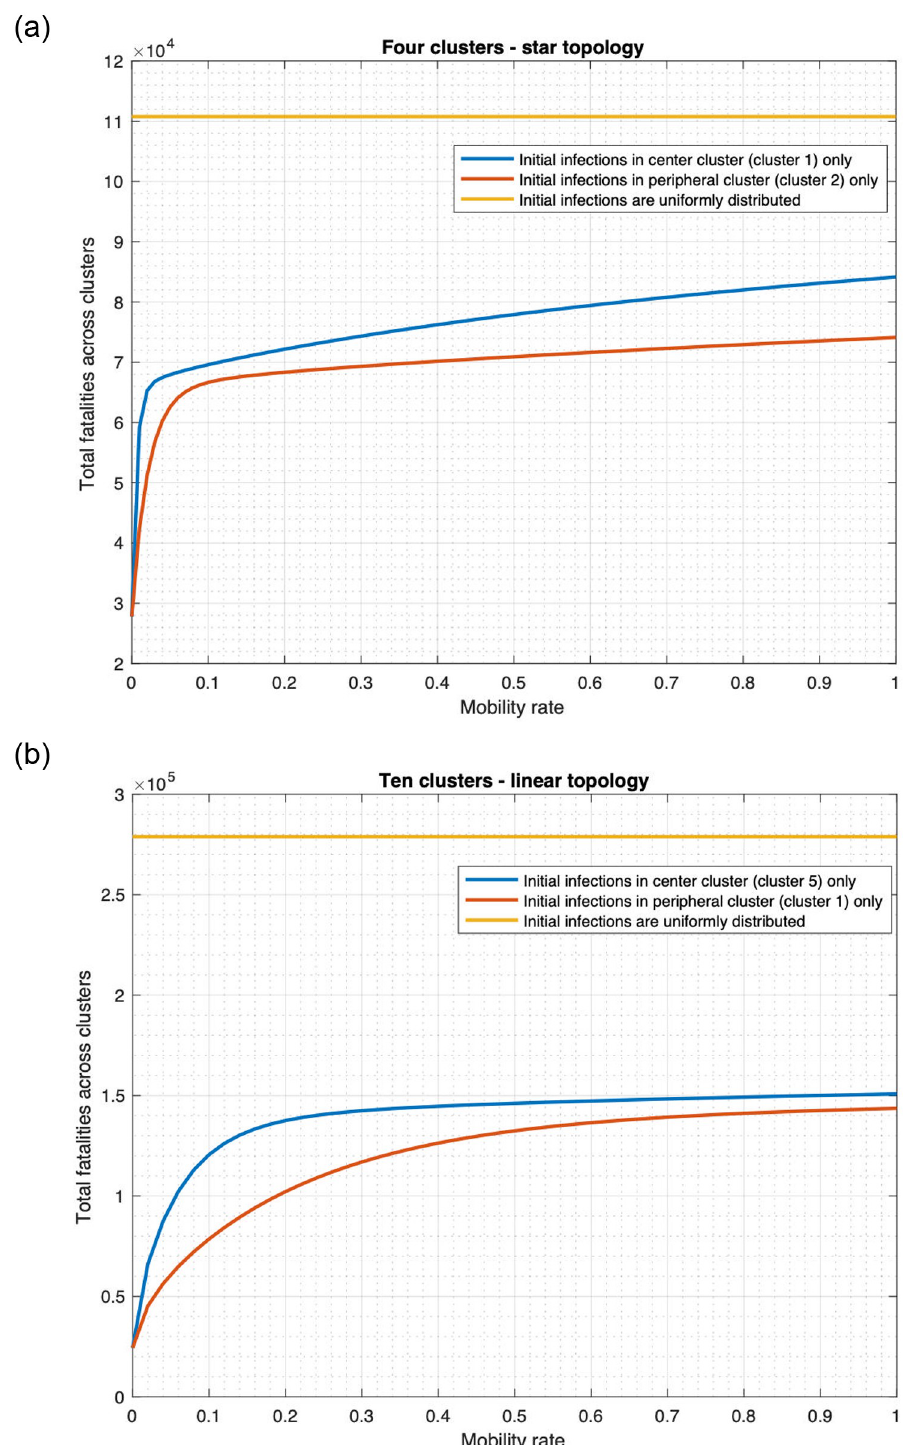
Fig 12. Relationship between fatality and mobility rate. (a) Star topology. (b) Linear topology.